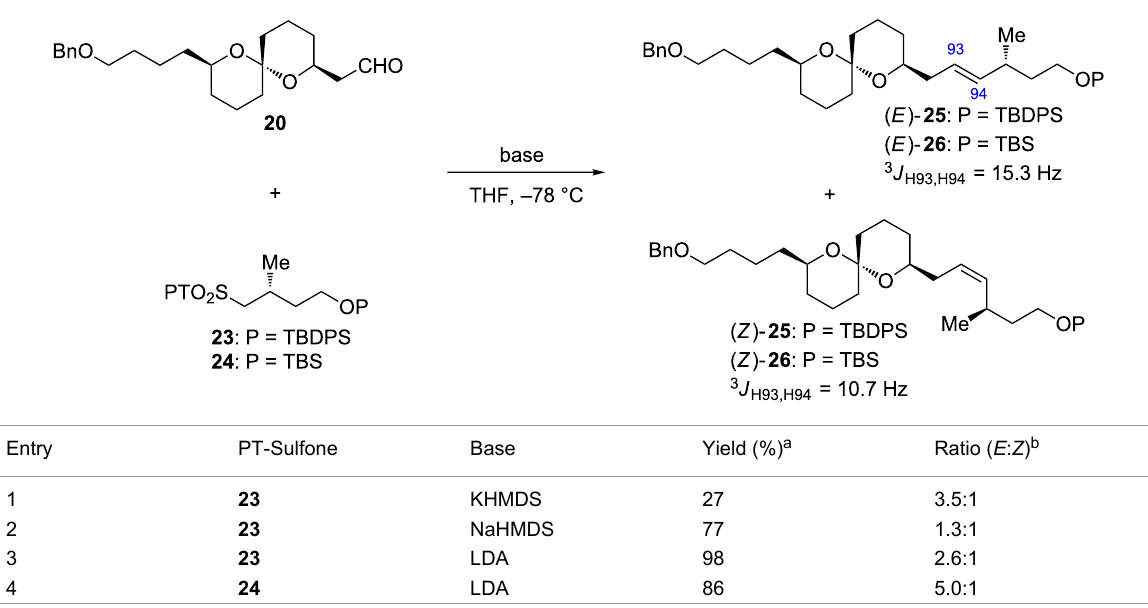
Table 1: Julia–Kocienski olefination between aldehyde 20 and PT-sulfones 23 and 24 .